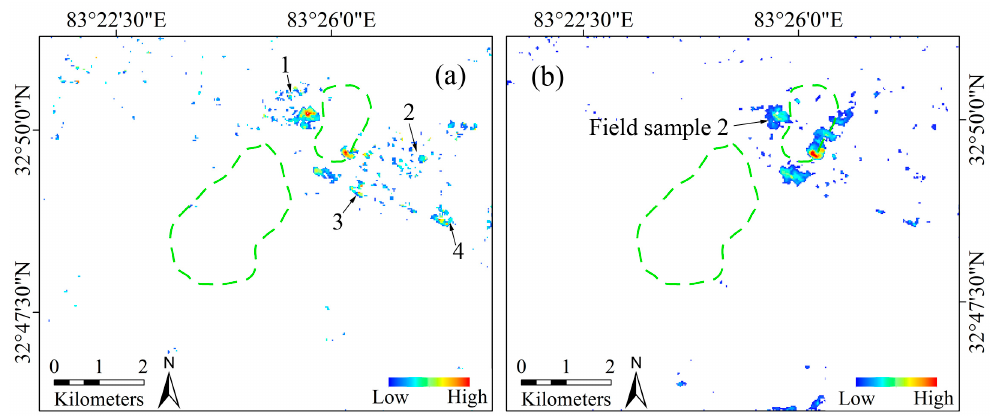
Figure 9. The abundance of Mg-OH group minerals of Duolong PCD. ( a ) Mg-OH 1 , ASTER RBD (B6 + B9)/B8 (Threshold 98.6%); ( b ) Mg-OH 2 , ASTER SWIR bands MTMF (Infeasibility < 5). The green dotted line shows the altered zone outline from field investigations of Duolong PCD. The white areas indicate background values.